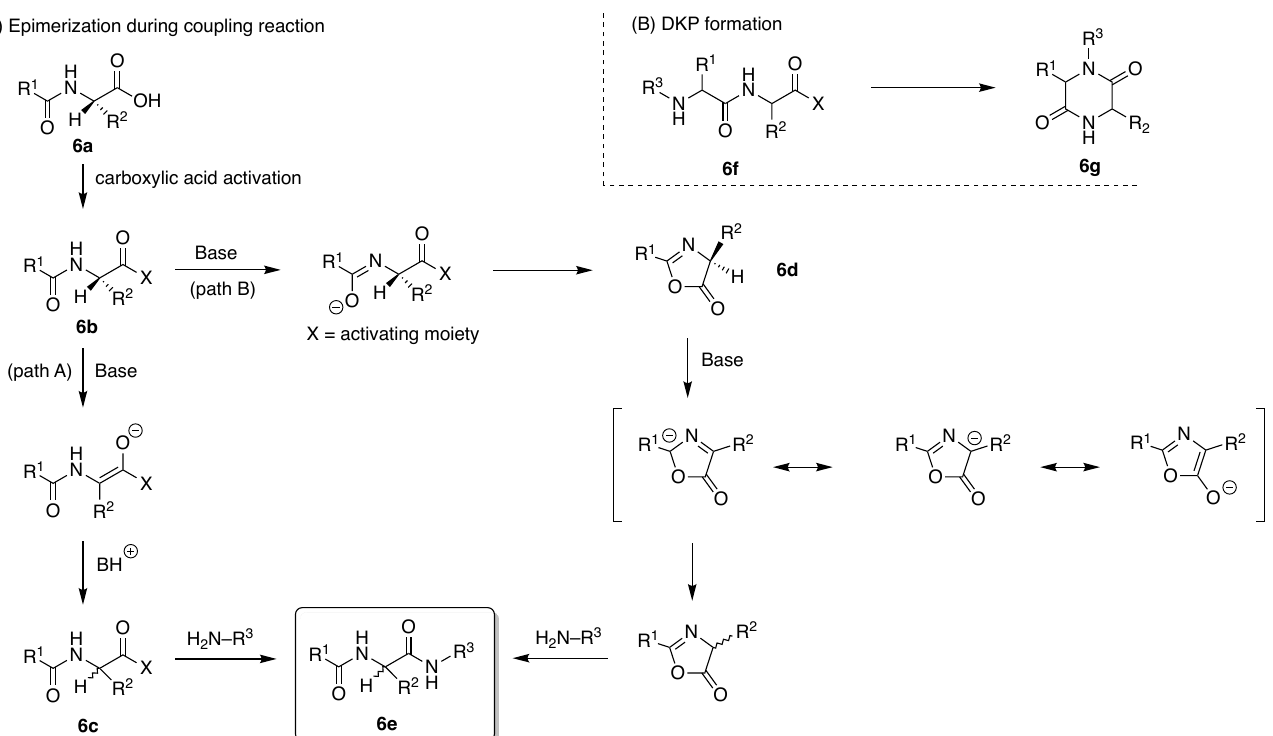
Figure 11. Side reactions during peptide synthesis including ( A ) epimerization and ( B ) DKP formation.